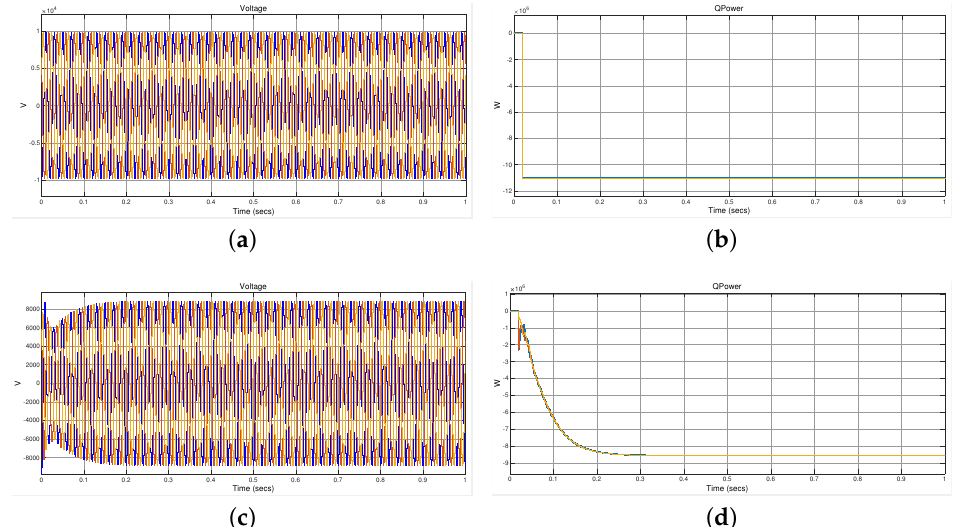
Figure 4. Voltage and Reactive power in utility grid when operated with all chargers and without chargers. ( a ) Voltage in utility grid when operated without chargers. ( b ) Reactive power in utility grid when operated without chargers. ( c ) Voltage in utility grid when operated with all chargers. ( d ) Reactive power in utility grid when operated with all chargers.